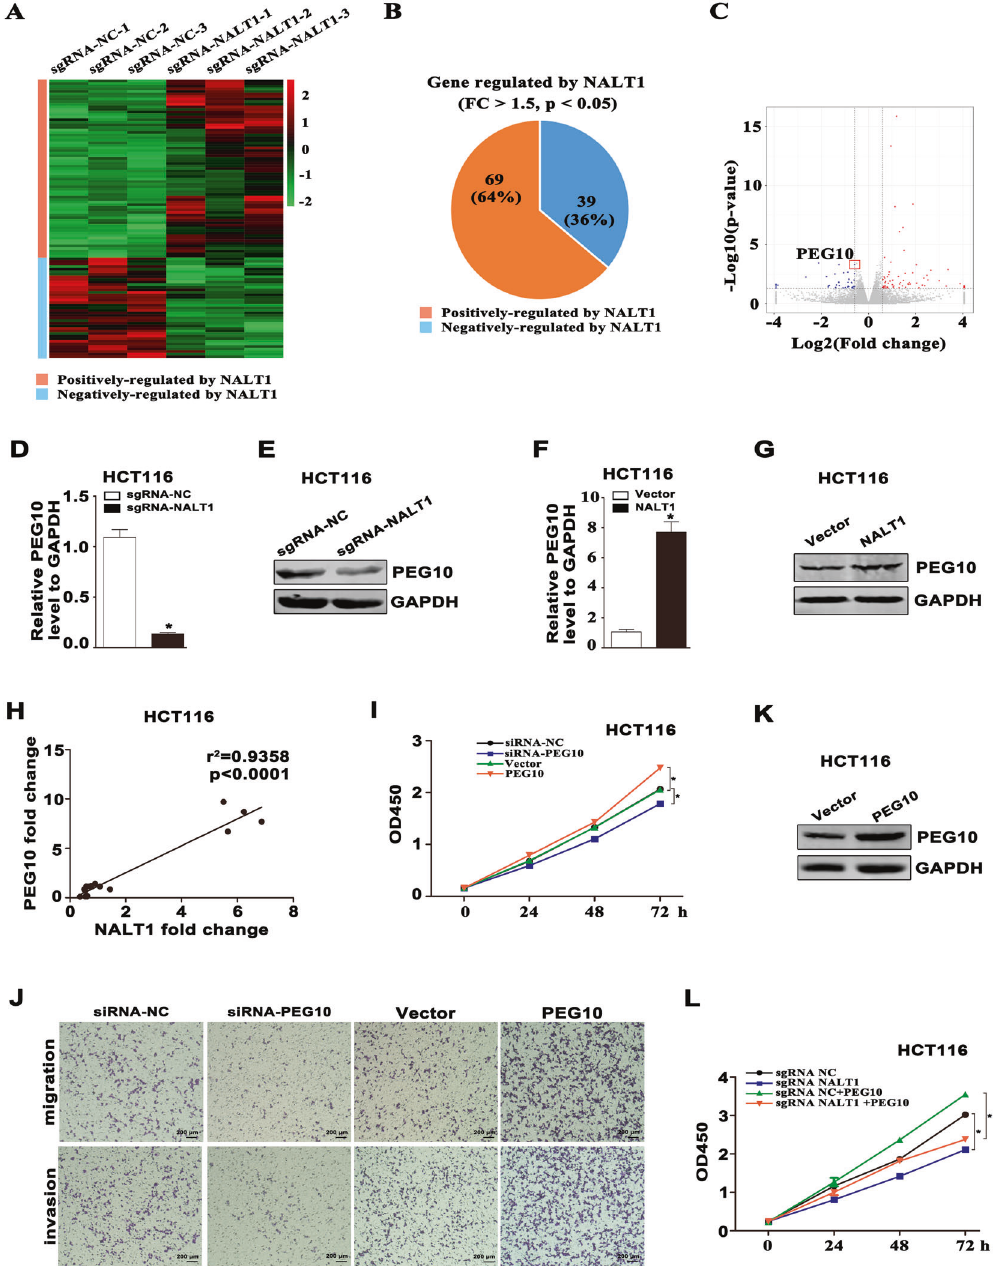
Fig. 4 NALT1 promotes PEG10 expression in CRC. A Heatmap revealing the signi fi cantly differentially expressed mRNA in NALT1-knockdown and NC HCT116 cells. Green and red denote downregulated and upregulated mRNAs, respectively. B Genes were negatively and positively regulated by NALT1, respectively (fold-change>1.5, q < 0.05). C Ten top genes regulated by NALT1 with fold-change>1.5 and p<0.05 are drawn in the volcano plot. D – G RT-qPCR and WB analyses of PEG10 expression after knockdown or overexpression of NALT1 in HCT116 cells. H Gene expression correlation between NALT1 (x) and PEG10 (y) in HCT116 cells ( R = 0.2106, p = 0.0317). I CCK8 assay was applied to measure the cell proliferation in PEG10-knockdown or overexpression HCT116 cells. K WB analyses the ef fi ciency of PEG10 eukaryotic expression plasmid in HCT116 cells. J Transwell assays were applied to measure the migratory and invasive capability of HCT116 cells with PEG10 knockdown or overexpression. L CCK8 assay was applied to measure the cell proliferation in NALT1-knockdown or NC HCT116 cells after transfection with PEG10 overexpression plasmid or